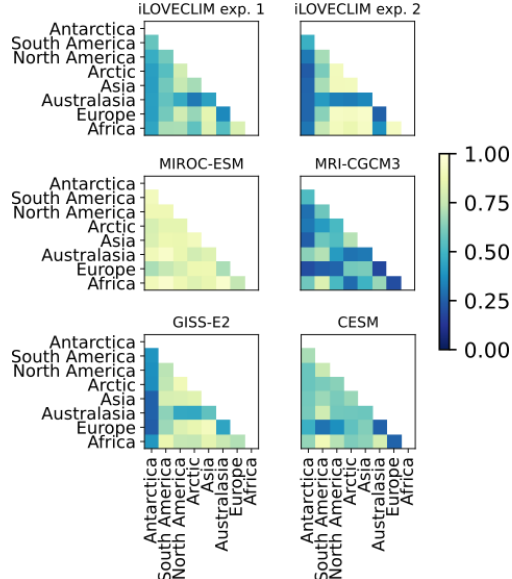
Figure 5. Inter-continental temperature correlations for i LOVECLIM ensemble members 1 and 2 and for the CMIP5 last millennium simulations. For the CESM results ensemble mean values were first calculated per grid cell before calculat- ing the inter-continental correlations. The i LOVECLIM results shown here are lagged correlations. See Fig. A2 for the results of all i LOVECLIM ensemble members, and see Fig. A3 for the non-lagged